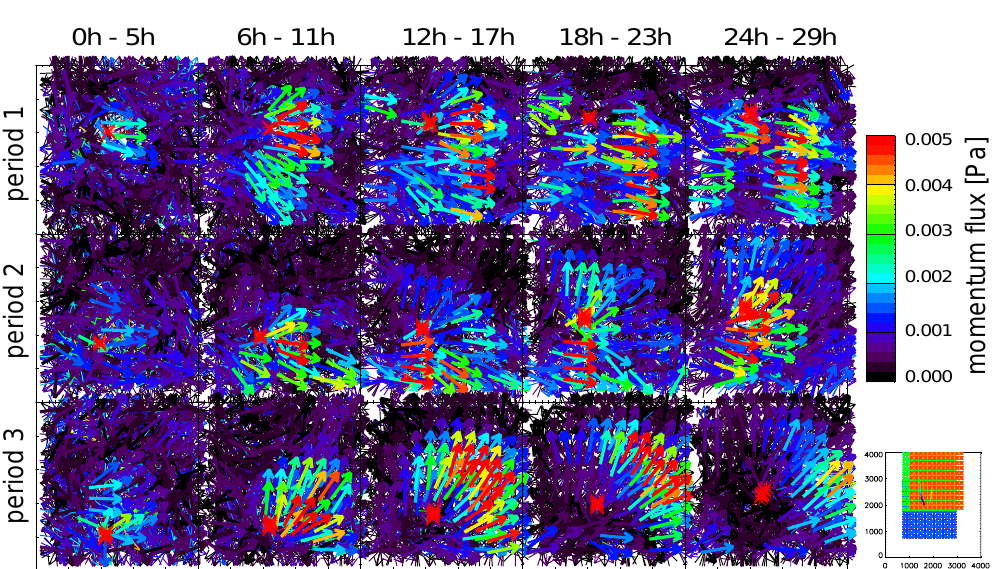
Fig. 9. As for Fig. 7 but for 189km × 189km × 10km analysis volume. Please note that the position of a momentum flux value corresponds to the center of an arrow (not the